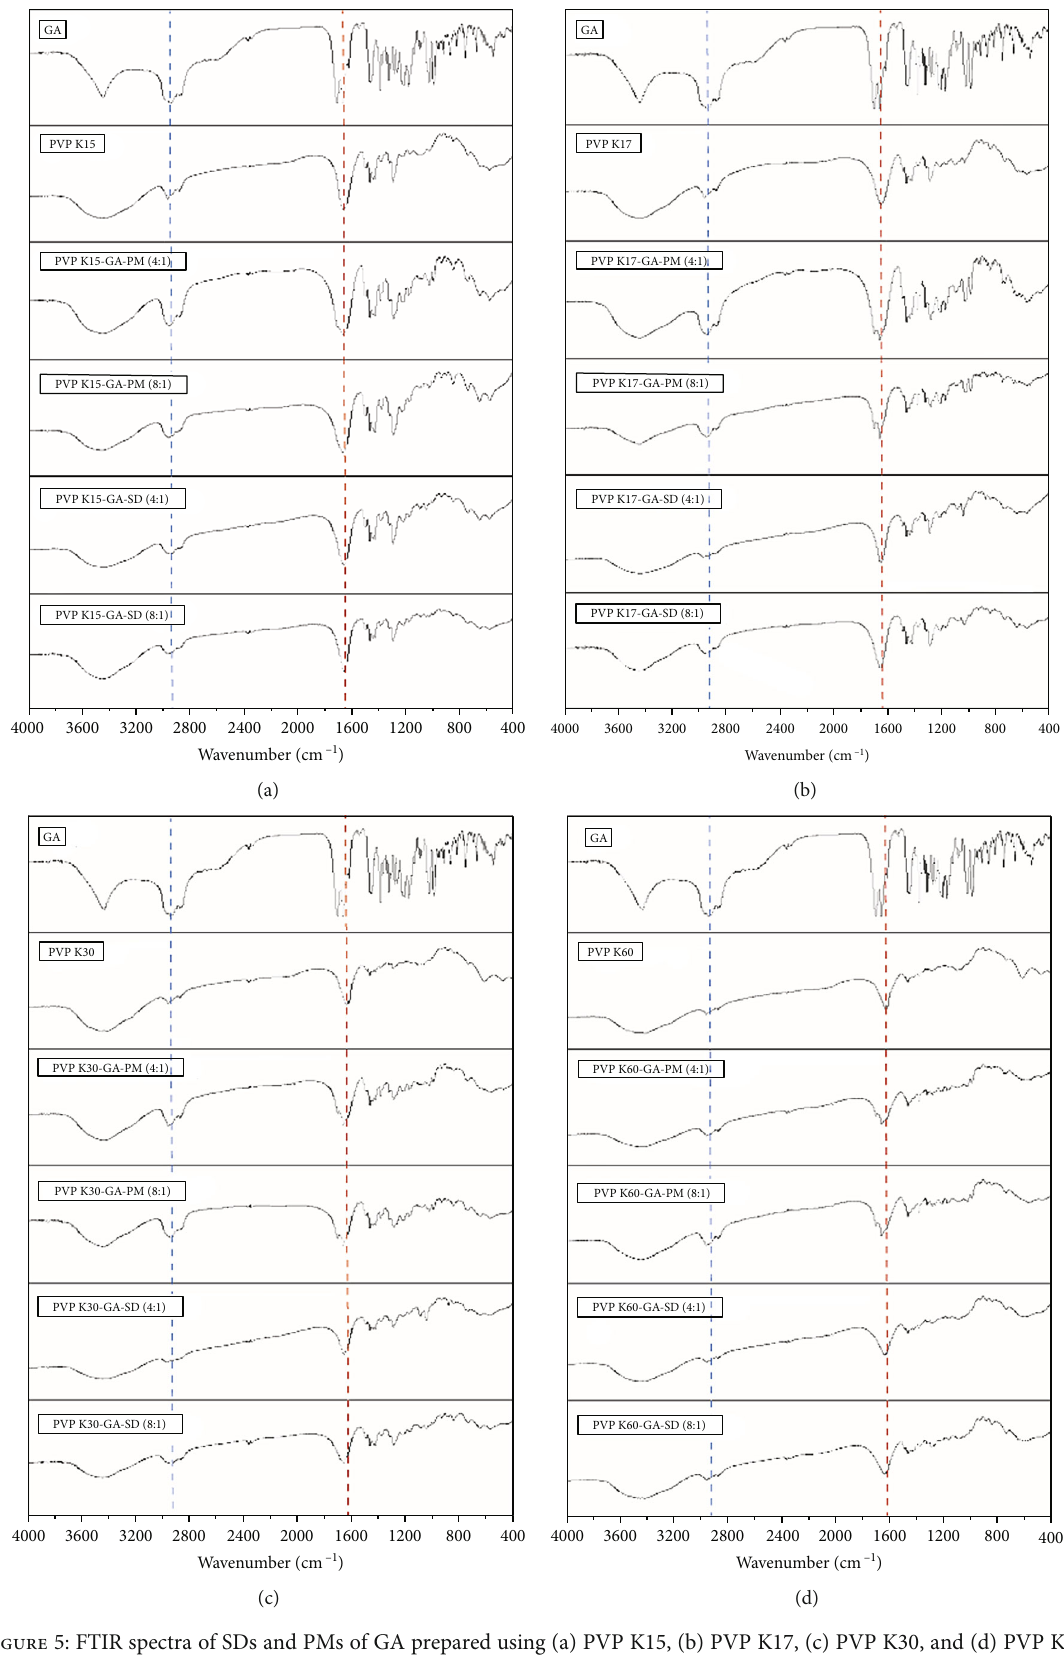
Figure 5: FTIR spectra of SDs and PMs of GA prepared using (a) PVP K15, (b) PVP K17, (c) PVP K30, and (d) PVP